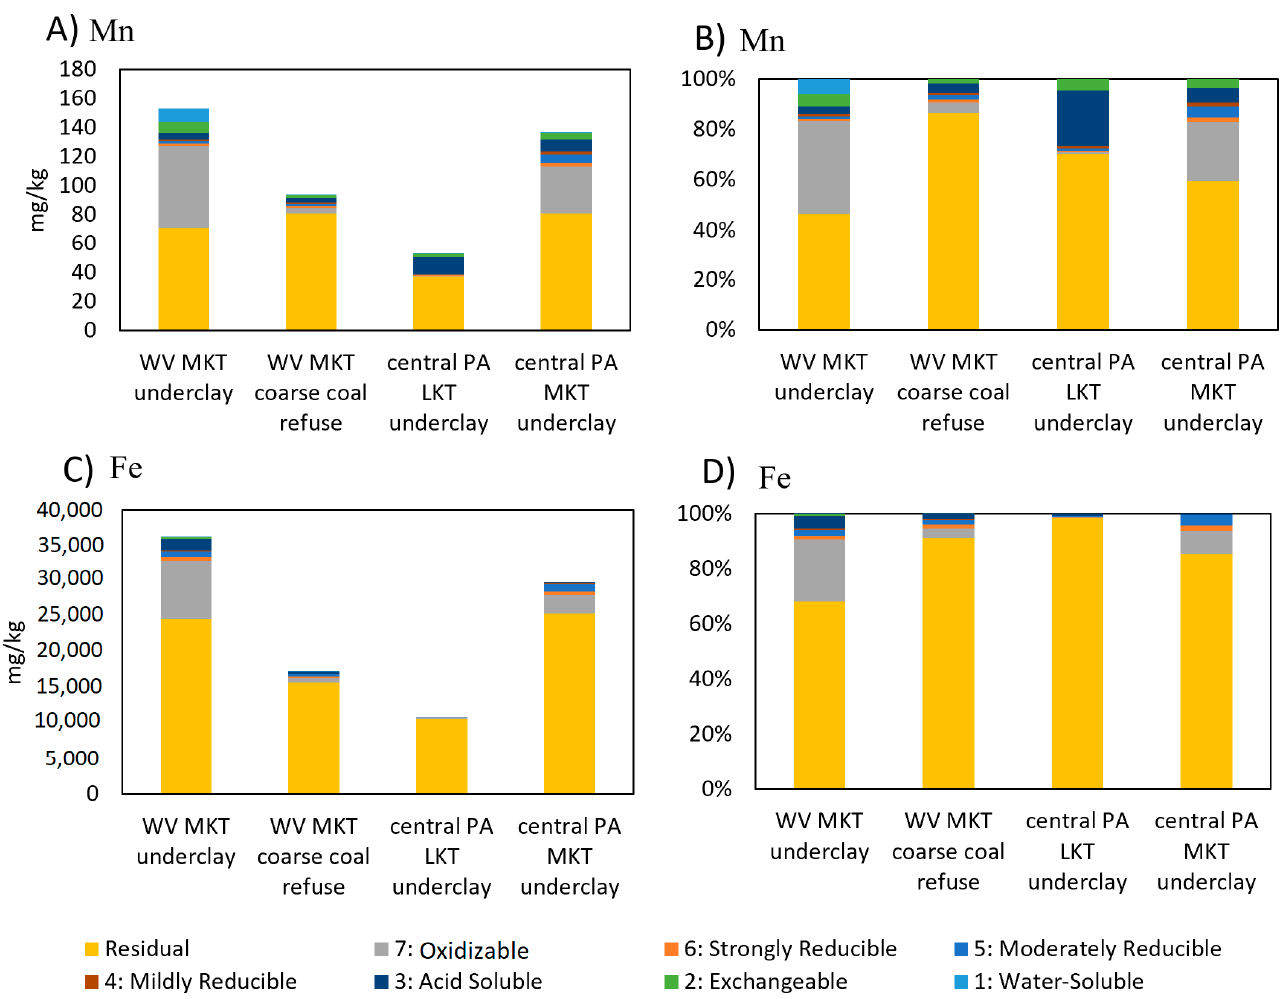
Figure 3. ( A ) Distribution of Mn from sequential extractions. ( B ) Plot of Mn distribution from sequential extractions normalized to percentage extraction. ( C ) Distribution of Fe from sequential extractions. ( D ) Plot of Fe distribution from sequential extractions normalized to percentage extraction.